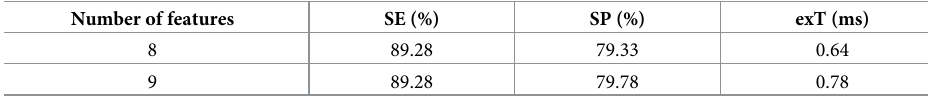
Table 4. Average performance of DT with different numbers of